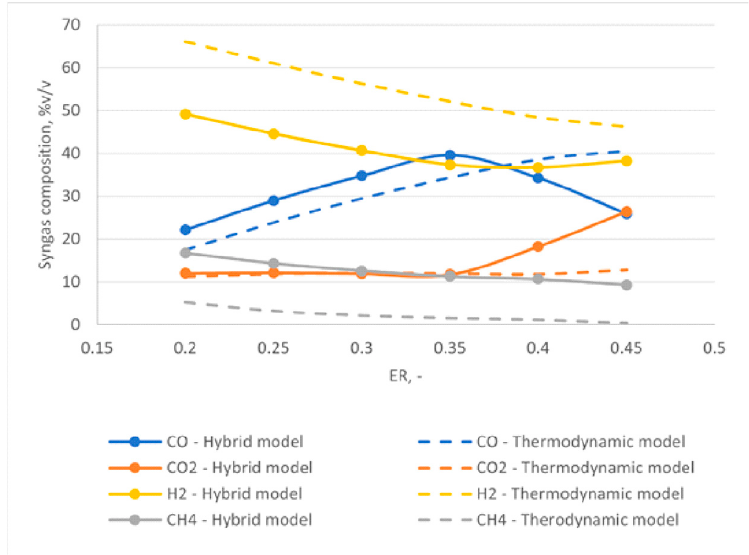
Figure 13. Comparison between new hybrid approach and thermodynamic model results: relative weights of CO, CO 2 , CH 4 , and H 2.